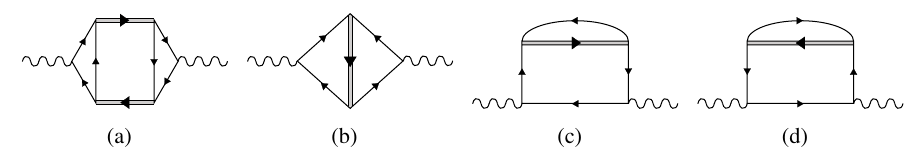
Figure 1: Diagrammatic representations of the Aslamasov-Larkin (a), Maki-Thompson (b) and density of states (c,d) terms with the diquark soft mode. The wavy and double lines are photons and the diquark soft modes,